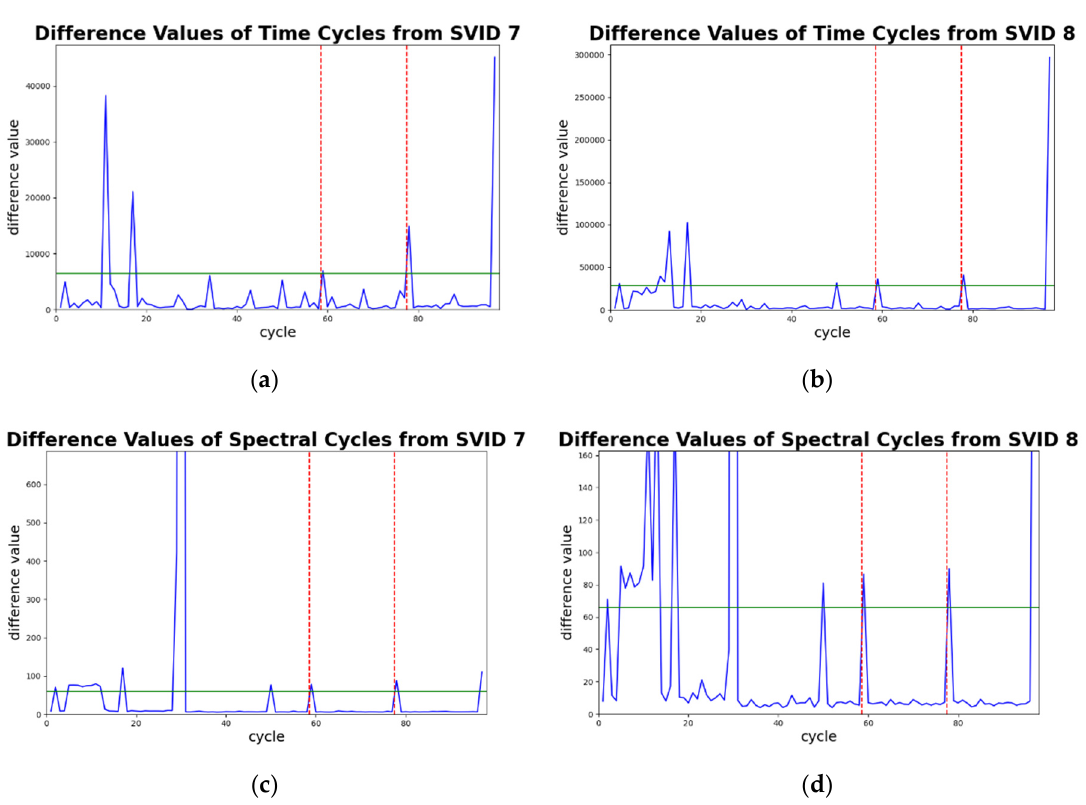
Figure 10. Detection of abnormal sequences by difference values from two different SVIDs: ( a ) the sample sequences of 7th SVID; ( b ) the sample sequences of 8th SVID; ( c ) ST of the sample sequences of 7th SVID; ( d ) ST of the sample sequences of 8th SVID.